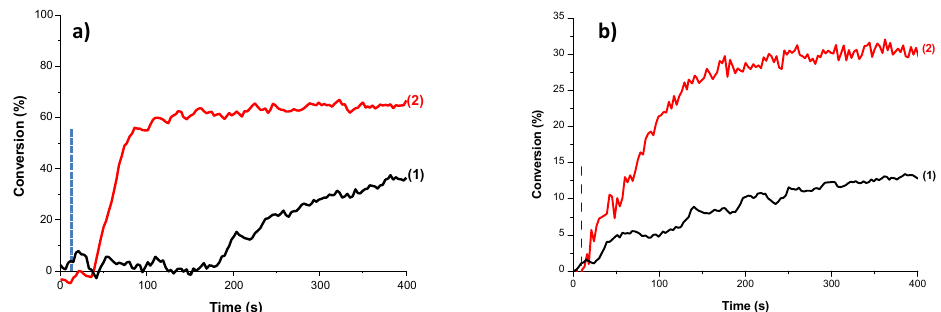
Figure 42. ( a ) Polymerization profiles obtained during the FRP of a BisGMA / TEGDMA blend in the presence of the two-component systems (1) Cu-43 / Iod (0.5 / 1% w / w ) and (2) Cu-44 / Iod (0.5 / 1% w / w ); ( b ) Photopolymerization profiles obtained during the FRPCP of EPOX in the presence of the three-component systems (1) Cu-43 / Iod / NVK (0.5 / 1 / 1% w / w / w ) and (2) Cu-44 / Iod / NVK (0.5 / 1 / 1% w / w / w ) upon irradiation with a LED at 405 nm (110 mW / cm 2 ). Reproduced with permission from the authors of [138], Copyright 2018 The Royal Society of Chemistry.